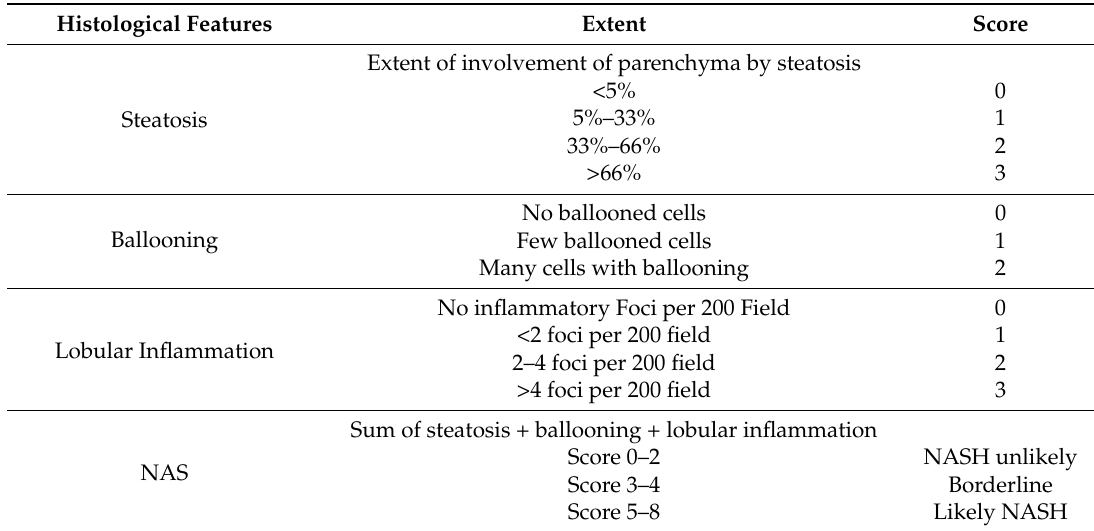
The NAFLD activity score (NAS) for the histopathologic diagnosis of nonalcoholic steatohepatitis (NASH) [84].